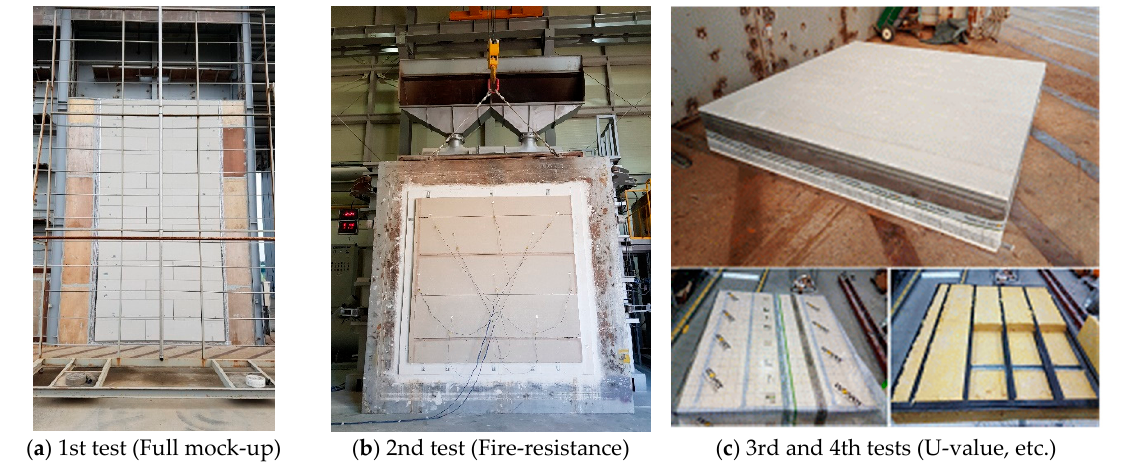
Figure 5. Test Figure 5. Test specimens. Figure 5. Test specimens.